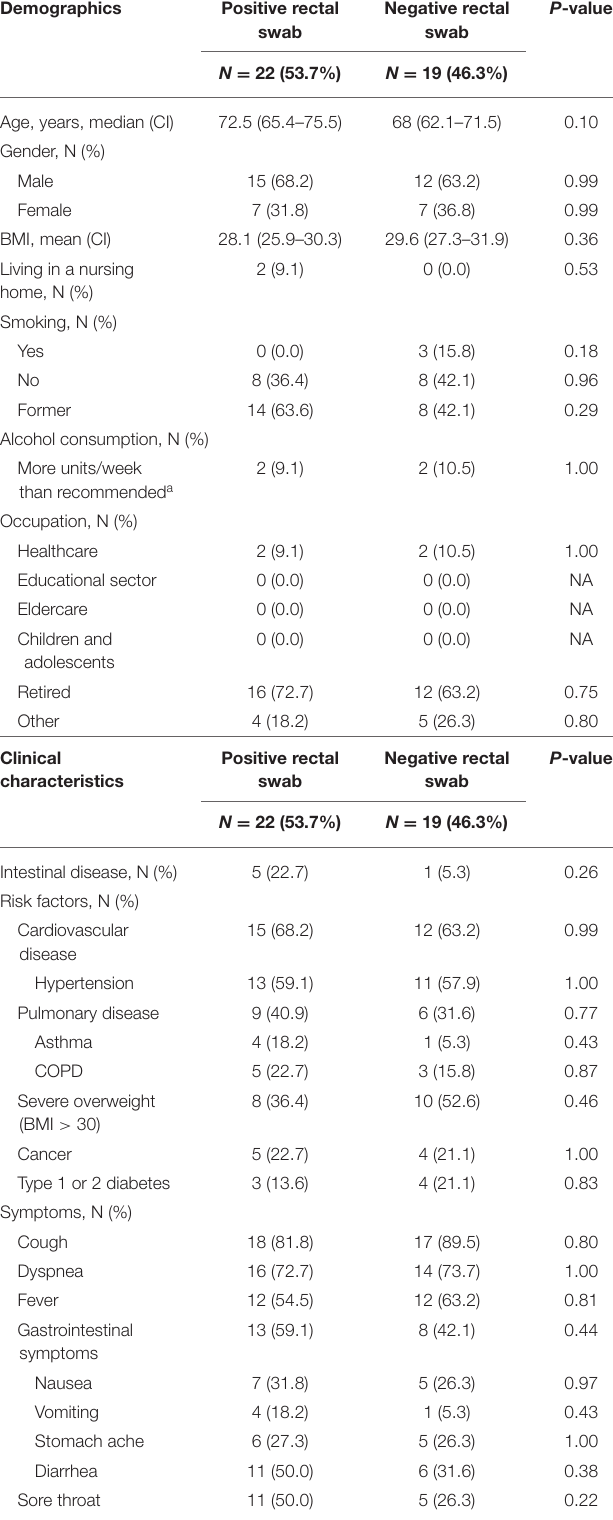
TABLE 2 | Demographic and clinical characteristics of hospitalized COVID-19 adult patients with positive and negative rectal swabs, respectively. Demographics